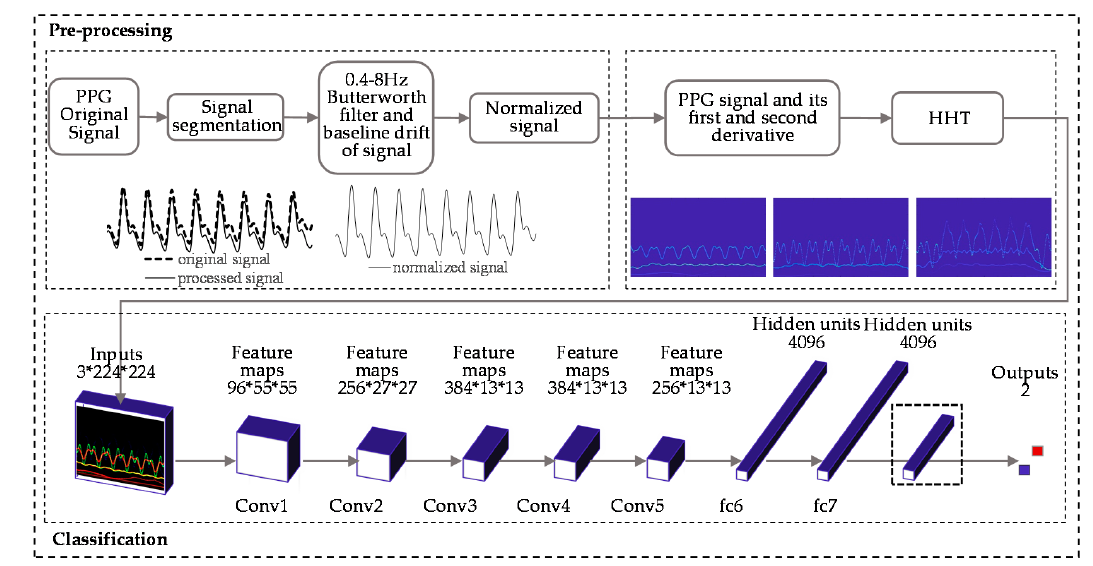
Figure 5. PPG signals processing procedure and the classification experiment (AlexNet).